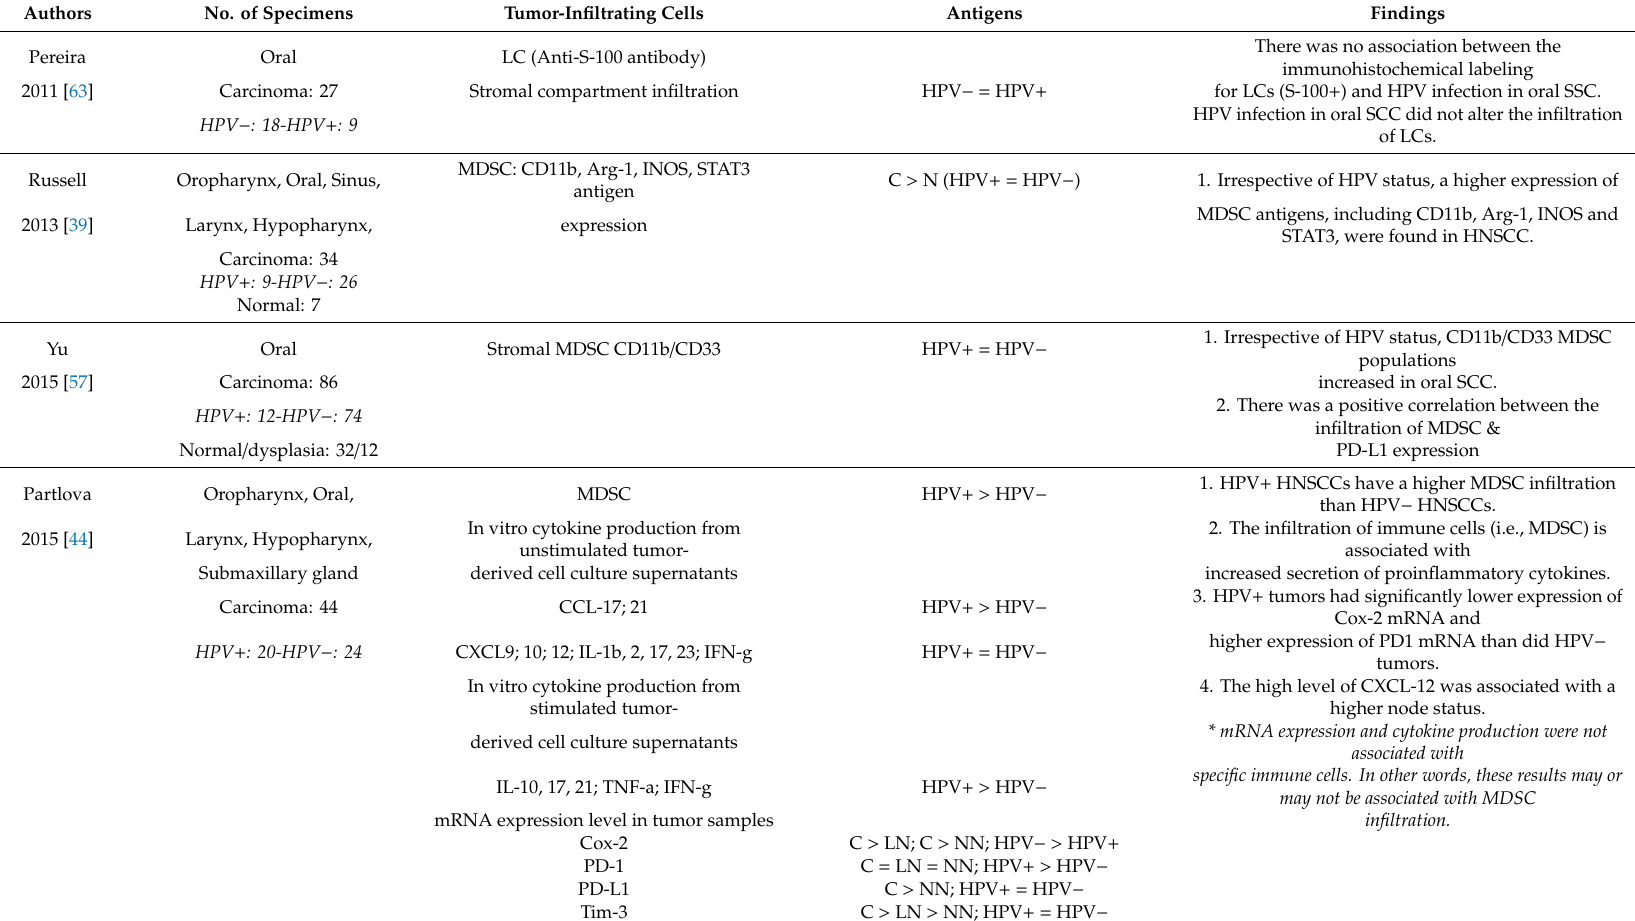
Table 6. Infiltration of Langerhans cells and myeloid-derived suppressor cells in HNSCC according to HPV